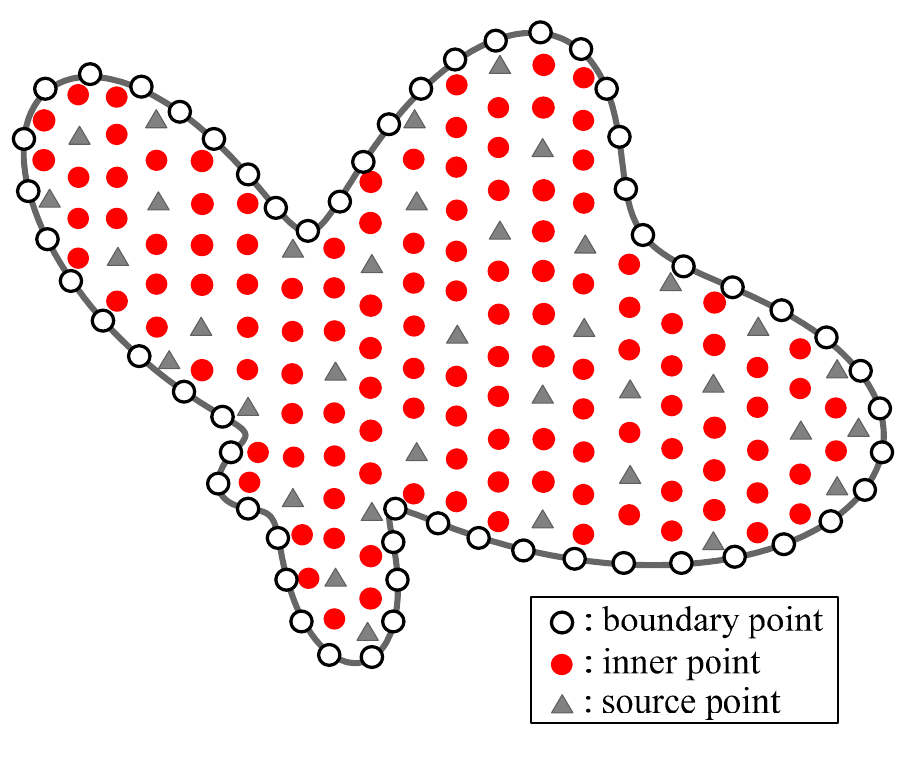
Mathematics 2020 , 8 , x FOR PEER REVIEW Figure 16. Layout of boundary, source and inner points. Figure 16. Layout of boundary, source and inner points.